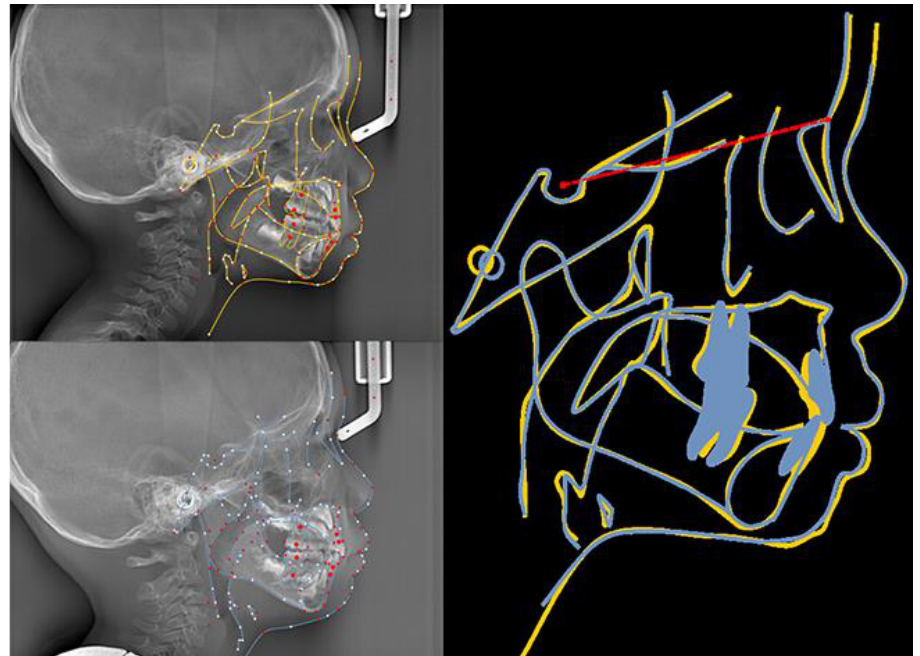
Figure 18. The initial and final lateral cephalograms and overlapping graphs of cephalometric trac- ing.